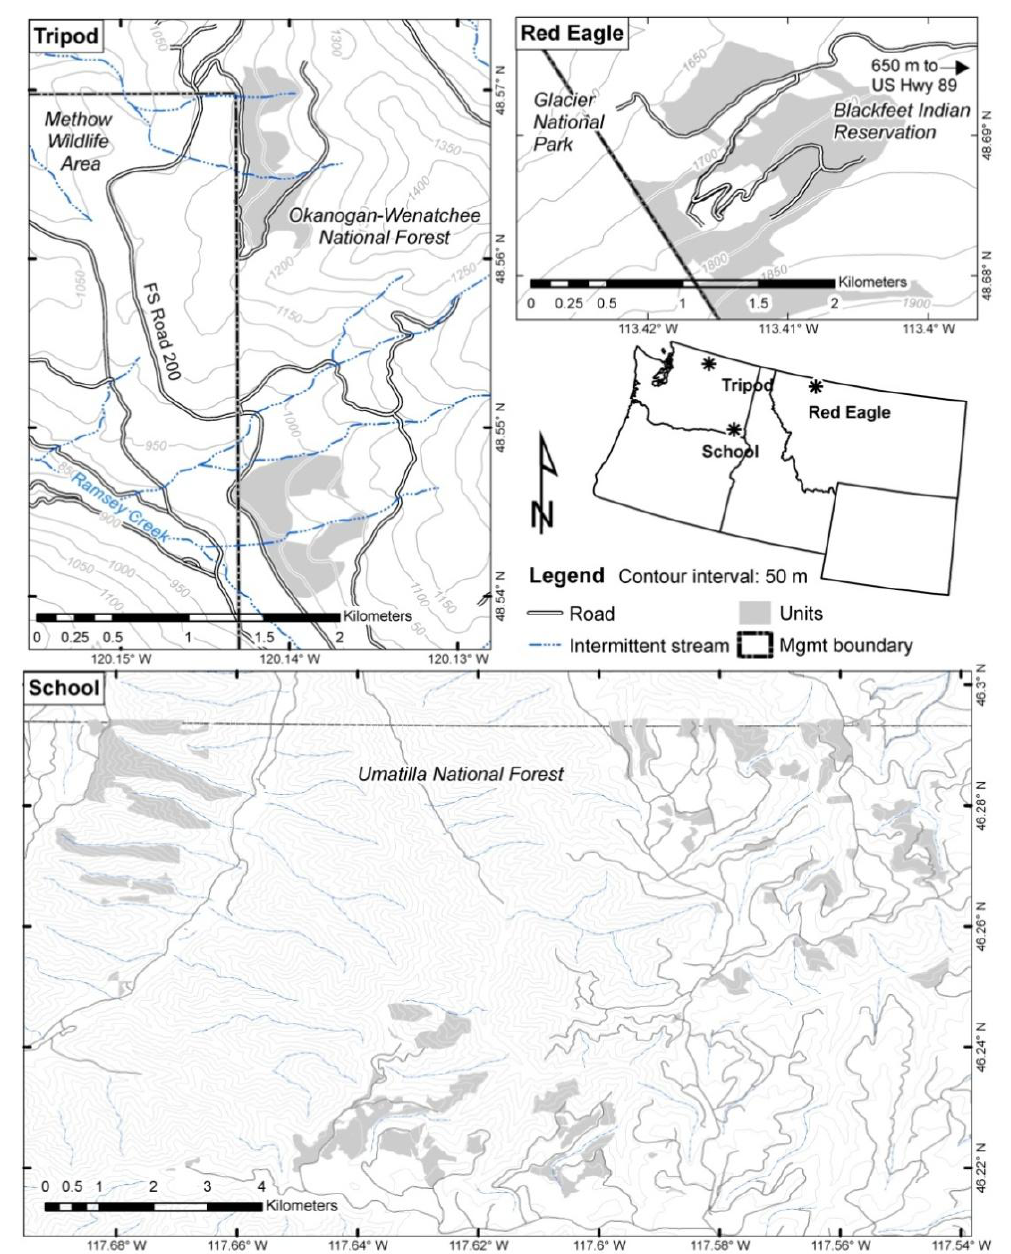
Figure 1. School Fire, Red Eagle Fire, and Tripod Fire study areas with salvage harvest units (areas)